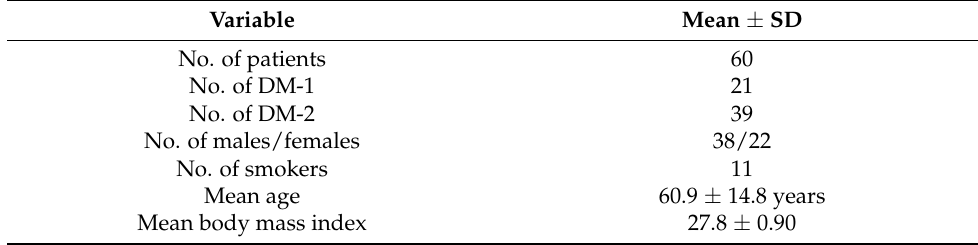
Table 1. Demographic characteristics of the included